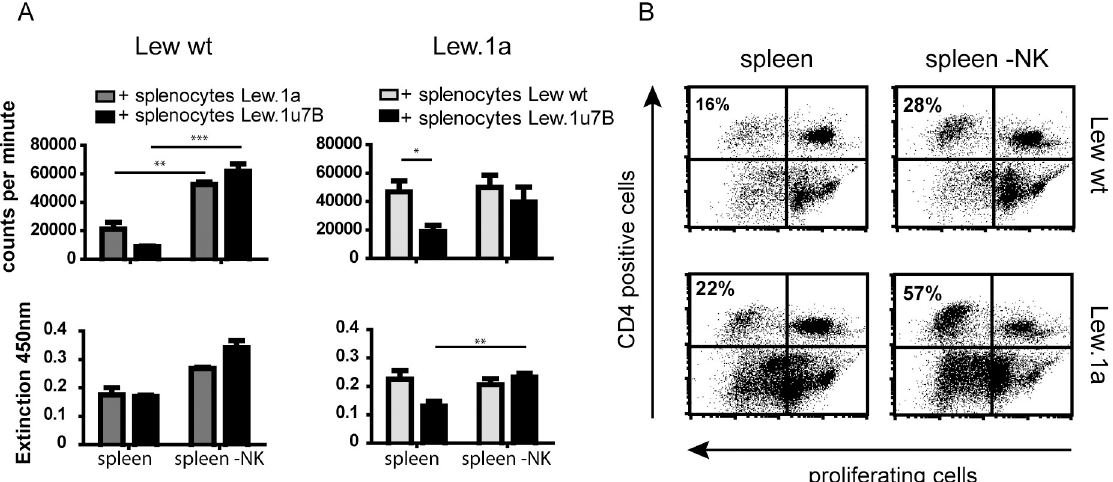
Fig 2. Distinct capacity of NK cells to control T cell activation, depending on the rat strain. (A) Proliferation (upper panel) and IFN- γ release (lower panel) of 2x10 5 na ï ve splenocytes derived from Lew wt and Lew.1a rats after in vitro stimulation with 2x10 5 irradiated splenocytes from the respective MHC disparate strains for 6 days. Responder splenocytes were either bulk or depleted of NK cells. The proliferation of T cells was highly controlled by NK cells in Lew wt rats, while Lew.1a rats showed a less consistent outcome in the absence of NK cells. The amount of secreted cytokine was highly related to the degree of proliferation, which indicates T cells as source of the detected IFN- γ . (B) Spontaneous proliferation of CMFDA-labelled Lew wt and Lew.1a splenocytes in the presence or absence of NK cells, respectively, incubated in medium alone for 6 days, was elevated in the absence of NK cells in both rat strains. Results are presented as exemplary dot blots or as mean ± SEM of at 4 least independent in vitro experiments. Significance is indicated with � for p-values � 0.05, �� for p-values � 0.005 and ��� for p-values � 0.0005. If no asterisk is shown in the respective graph the results were not significantly